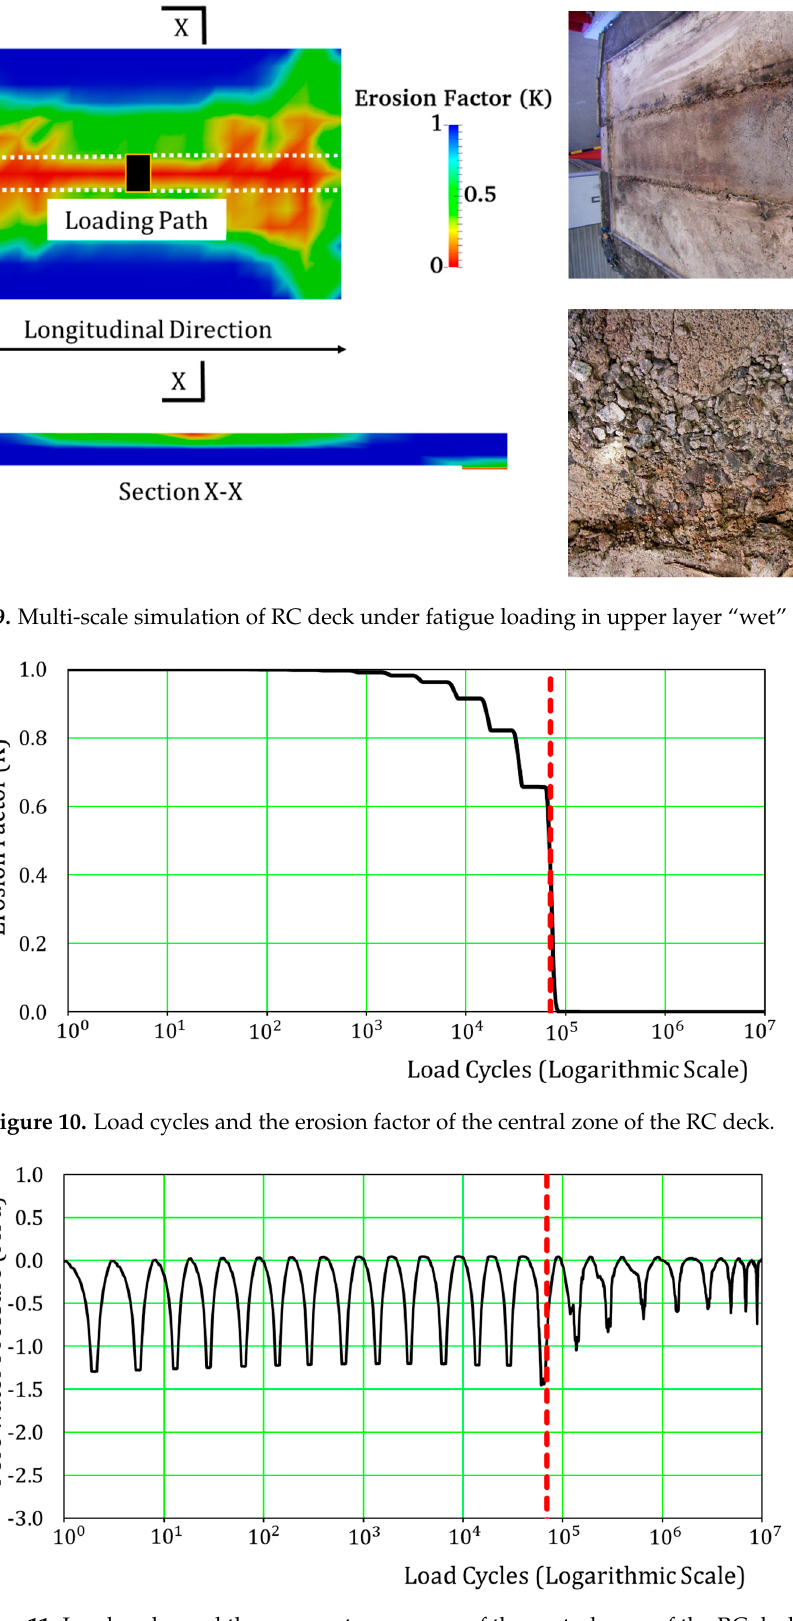
Figure 12. Load cycles and the top compressive stresses of the transverse direction of the central zone of the RC deck.